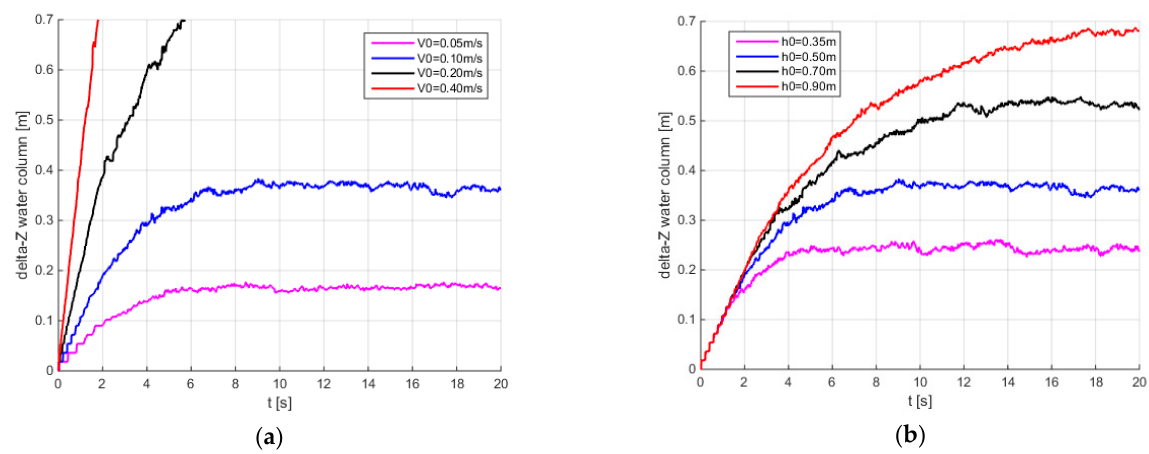
Figure 12. Variation of water column height. ( a ) Influence of gas velocity. ( b ) Influence of initial column height. For this application has been selected a gas velocity of 0.12 m/s and an initial water column height of 0.5 m.